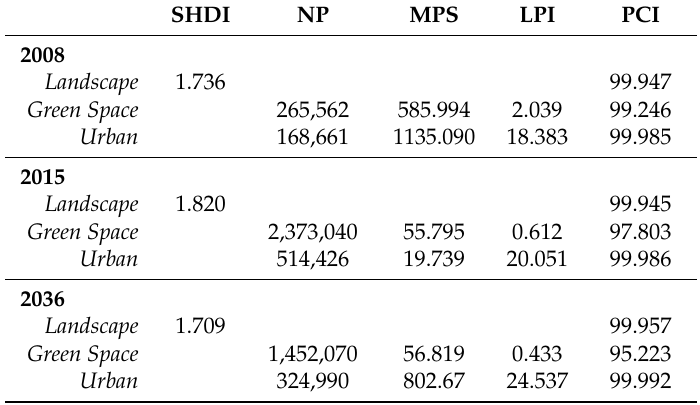
Table 7. Spatial metrics of the Philadelphia landscape, urban areas, and green space: Shannon’s diversity index (SHDI), number of patches (NP), mean patch size (MPS), largest patch index (LPI), and patch cohesion index